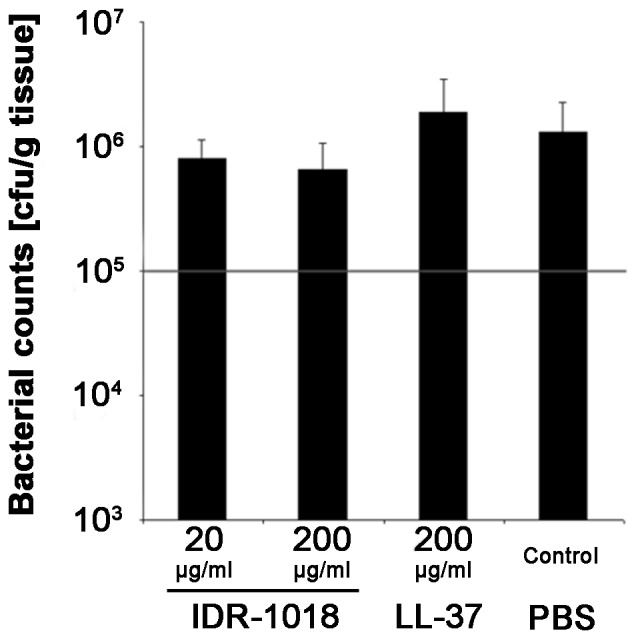
Assessment of bacterial colonization in S. aureus infected, porcine skin on day 10 after infection.Wounds were treated with the indicated concentrations of IDR-1018 or LL-37 (positive control). PBS served as negative control. Standard deviation was assessed as SEM.